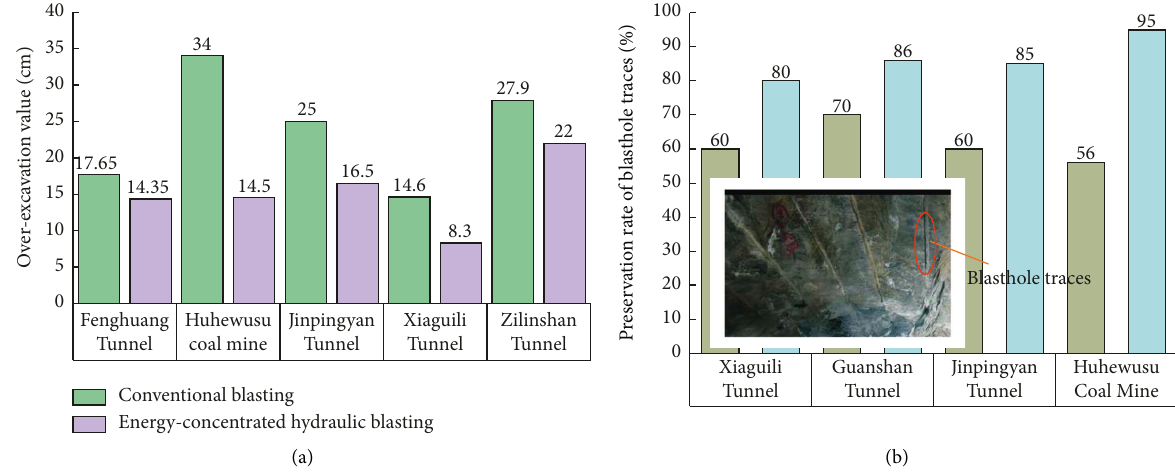
Figure 11: Comparison of smooth effect. (a) Overexcavation value. (b) Preservation rate of blasthole traces [47–62].